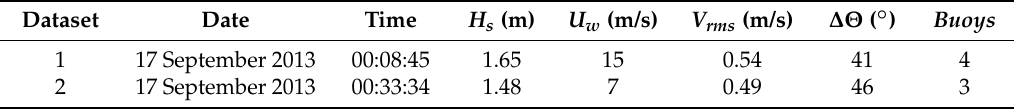
Table 1. Environmental statistics for both radar datasets used in this study. Shown in the table is the date and time the dataset was collected, as well as the significant wave height ( H s ) as measured by the wave buoys, wind speed ( U w ) as measured by a shipboard anemometer, root mean squared surface velocity ( V rms ) as measured by the wave buoys (averaged over all buoys in the radar FOV), angle between the two wave systems ( ∆Θ ) during dataset collection based on radar derived directional wave spectra, and the number of buoys in the radar